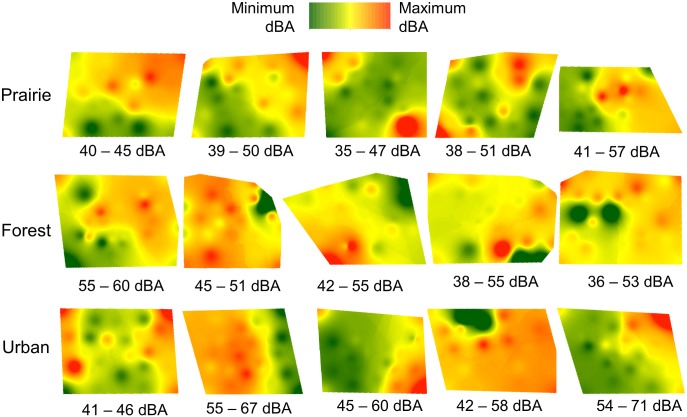
Sound maps of ambient conditions across each of five sites in each of three habitats.Maps were generated using full arrays of 24 microphones and show overall sound pressure levels (SPL, dBA). Note that the color scale is the same for all maps, but the actual SPLs reflected by the scale differ across maps and are indicated by the range of values below each map; we presented each with a unique scale to best visualize spatial variation in SPLs within a site. Maps within each habitat are ordered from the smallest to the largest range of SPLs within a given habitat type.